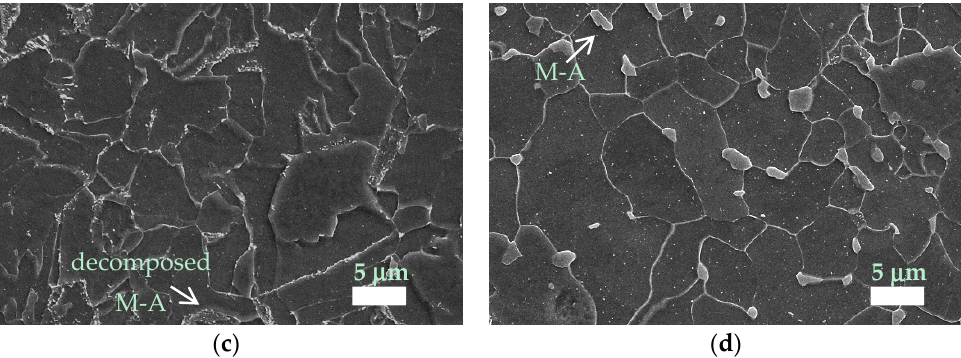
Figure 2. SEM micrographs from ( a ) straight stretch, ( b ) extrados , ( c ) extrados tempered at 600 °C, and ( d ) straight stretch normalized at 900 °C.